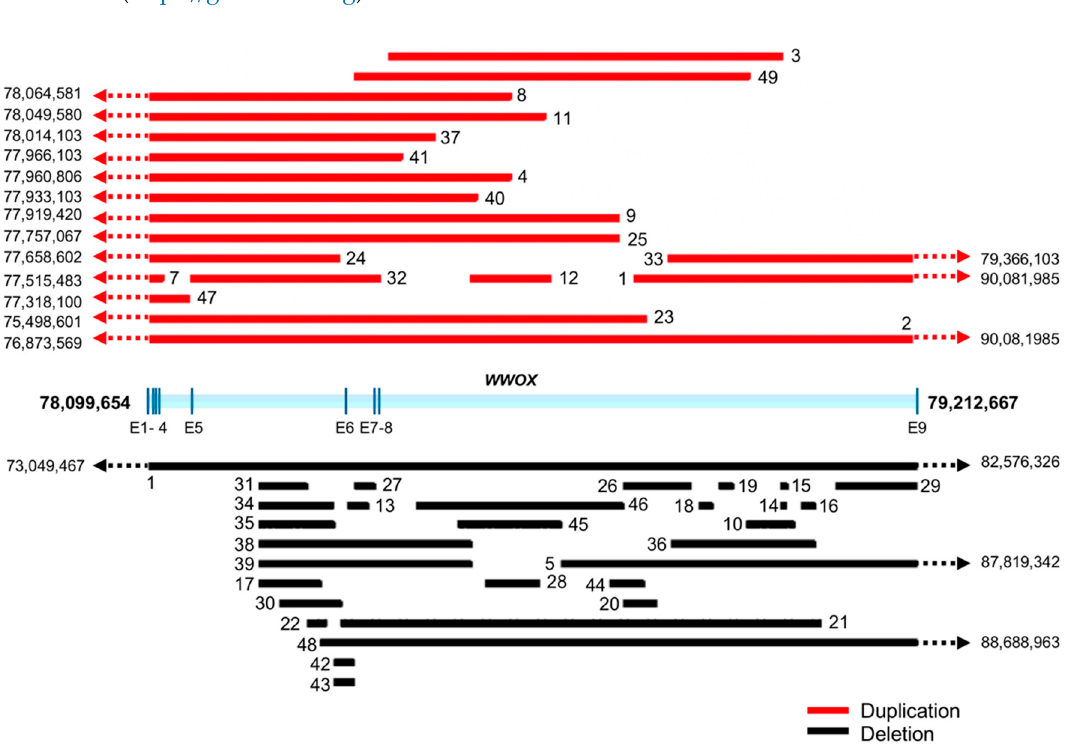
Figure 8. WWOX germline copy number variants (CNVs) in autism spectrum disorder (ASD). Distribution of WWOX locus CNVs associated with ASD and ID cases obtained from the AutDB database (http://www.mindspec.org/autdb.html). CNVs are mostly intragenic; however, additional larger variants with only one of the breakpoints within the genomic region spanned by this gene are also observed. Numbers next to dotted lines with arrowhead indicate coordinates of chromosomal breakpoints beyond the WWOX locus (human genome assembly GRCh38/hg38). Numbers 1–49 shown next to CNV bars correspond to case numbers described in Table S2.